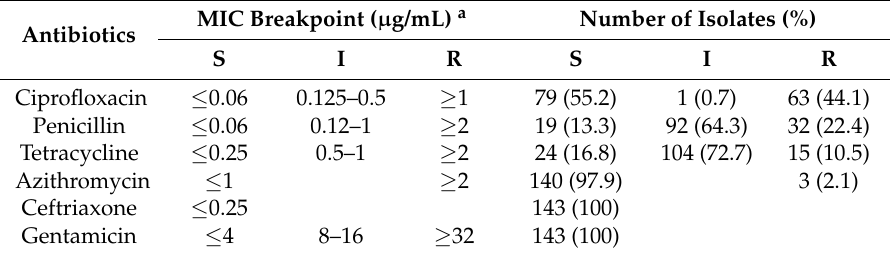
Table 1. Antimicrobial susceptibility profiles of Neisseria gonorrhoeae (NG) isolates ( n = 143).